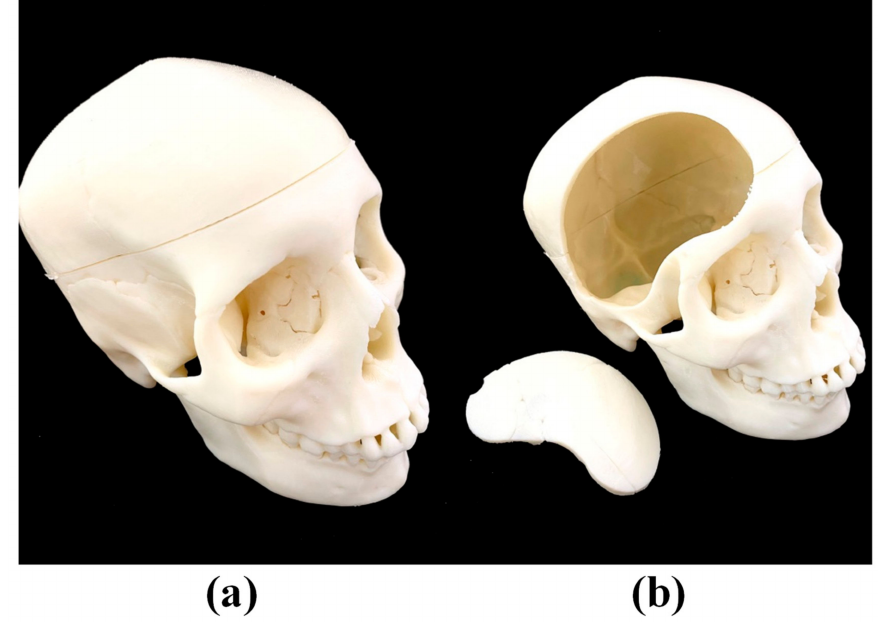
Figure 3. ( a ) The overall 3D-printed skull; ( b ) how a piece of cranium located on the right side of the forehead can be removed to simulate a